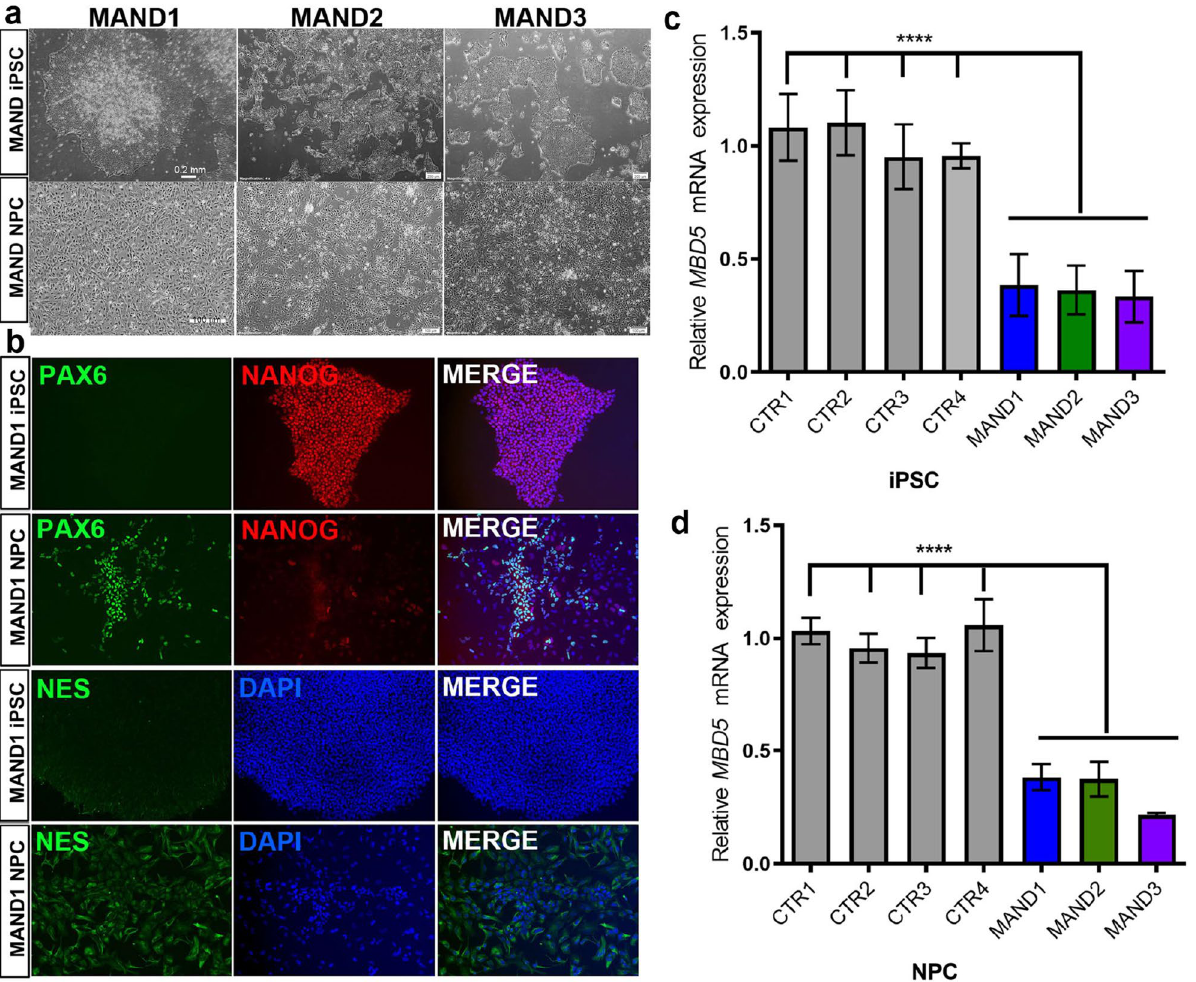
Figure 2. Generation of iPSC and NPC lines from individuals with MAND. ( a ) Bright-field images of undifferentiated iPSC lines from MAND1-3 (top row panel, l to r). Lower panel images are three NPC lines derived from MAND1-3 iPSC lines, respectively (l to r). After two weeks of neuronal induction, images were captured. Bars, 0.2 mm. ( b ) Immunostaining of MAND1 iPSC (1 st row) and MAND1 NPC (2 nd row) for neural progenitor cell marker PAX6 (1 st column) and pluripotent cell marker NANOG (2 nd column and 3 rd for merged). Immunostaining of MAND1 iPSC and MAND1 NPC for NES (3 rd and 4 th rows, respectively). ( c, d ) qRT-PCR analysis confirmed ~ 50% reduction of MBD5 mRNA expression in MAND iPSC ( c ) and NPC lines ( d ) when compared with control iPSC and NPC lines, respectively. p < 0.0001. Quantification of the test gene ( MBD5 ) was calculated relative to that of the housekeeping gene, GAPDH . All expression values were calculated relative to control levels set at 1.0. Error bars represent the SEM. **** p < 0.0001, n = 3 independent biological replicates performed in triplicate, GraphPad Prism 8.4.2